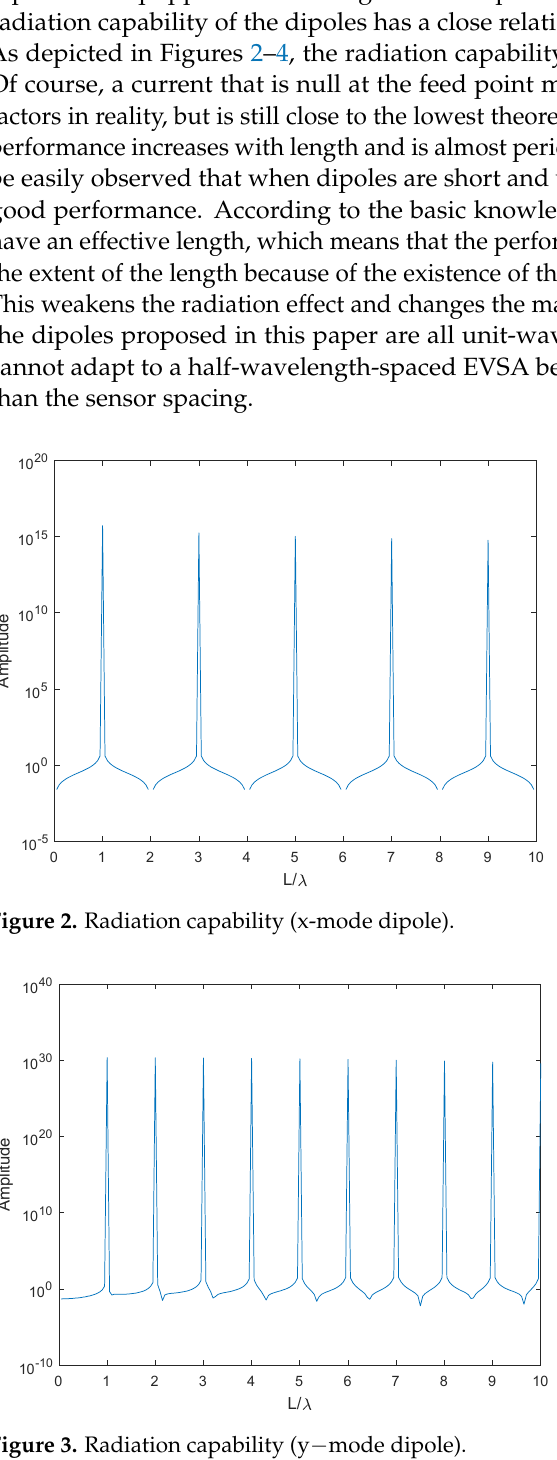
Figure 4. Radiation capability (z − mode dipole). 3.2. Array Aperture and Mutual Coupling According to the observations presented in the previous section, a unit-wavelength electric dipole was introduced in order to improve the radiation performance. In this case, the half-wavelength-spaced array is no longer applicable. Therefore, there is a demand for sparseness in the array structure. As a result, the proposed TCA fits well with the use of long dipoles, as well as extending the array aperture. First, compared with the triad and six-component structures [37], as demonstrated in Figure 5, the proposed TCA structure separately distributes the three dipoles from one point to different locations, which obvi- ously extends the array aperture compared to those of the triad and six-component struc- tures with the same dipole number. As a benefit of this separation, the inter-polarization coupling (IPC) generated by the orthogonal dipoles in a point is eliminated but the ability to receive vector signals is retained. In addition, the proposed array has sparse array spac- ing of over the half-wavelength. The dipole spacing of the three subarrays is